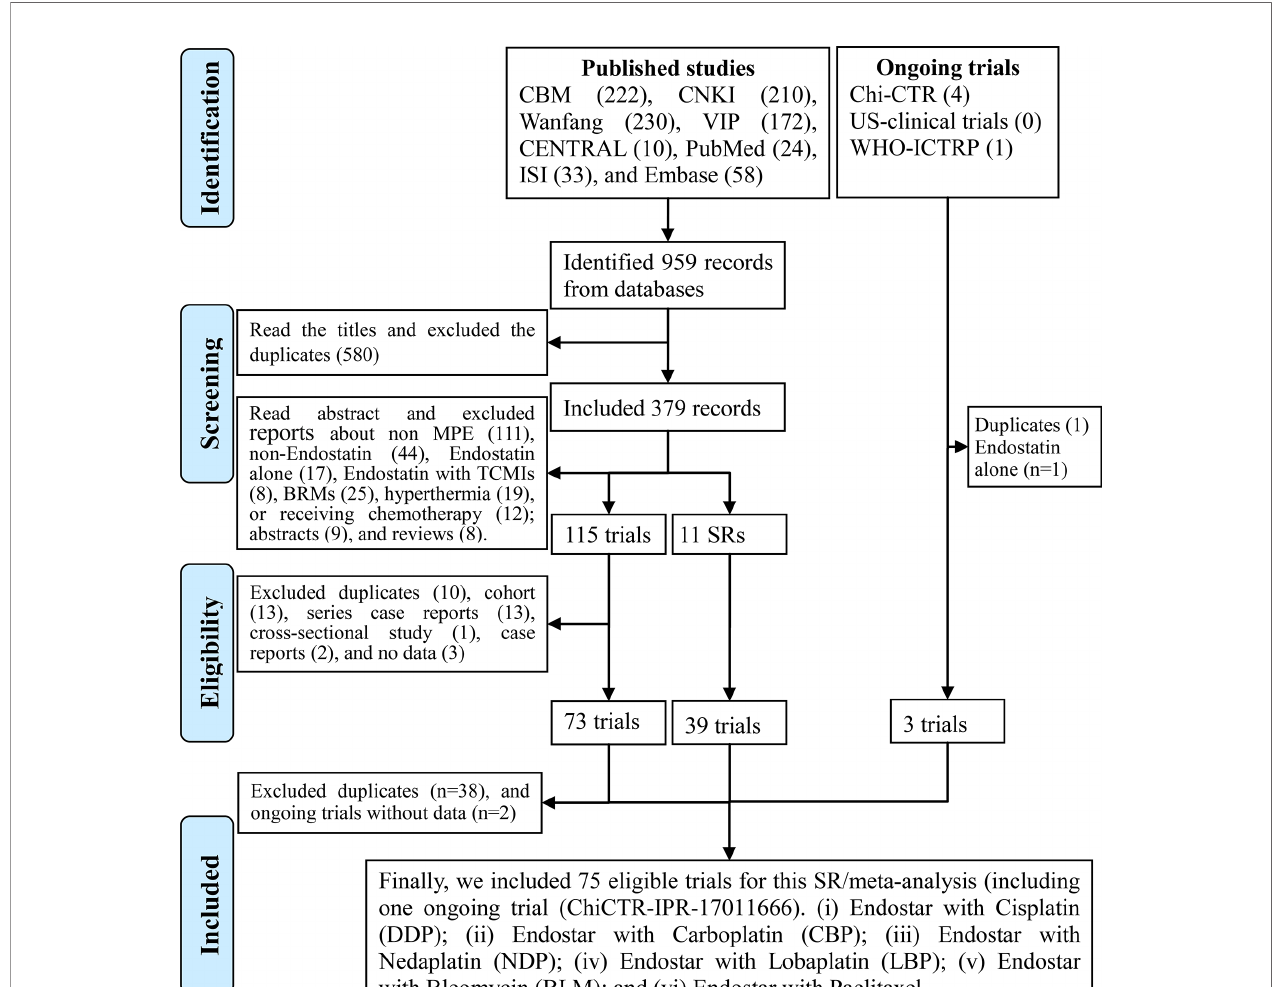
FIGURE 1 | Preferred Reporting Items for Systematic reviews and Meta-Analyses (PRISMA) 2009 fl ow diagram for the identi fi cation of eligible